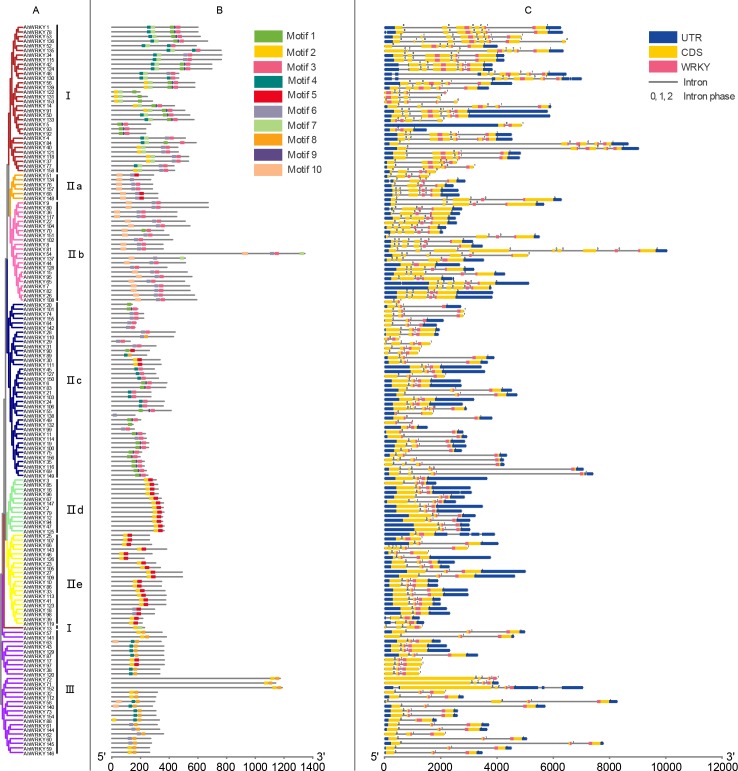
Structure characterization of AhWRKY gene family.A Maximum Likelihood (ML) phylogenetic tree of AhWRKYs. The various groups were distinguished in different colors. B The conserved motifs of AhWRKYs. The 10 motifs were displayed in different-colored boxes. For details of motifs referred to S1 File. C The structures of AhWRKYs. The untranslated 5′- and 3′-regions were represented by blue boxes. The yellow boxes and gray lines indicated CDS and introns, respectively. The WRKY domains were highlighted by red boxes. The introns phases 0, 1 and 2 were indicated by numbers 0, 1 and 2, respectively.